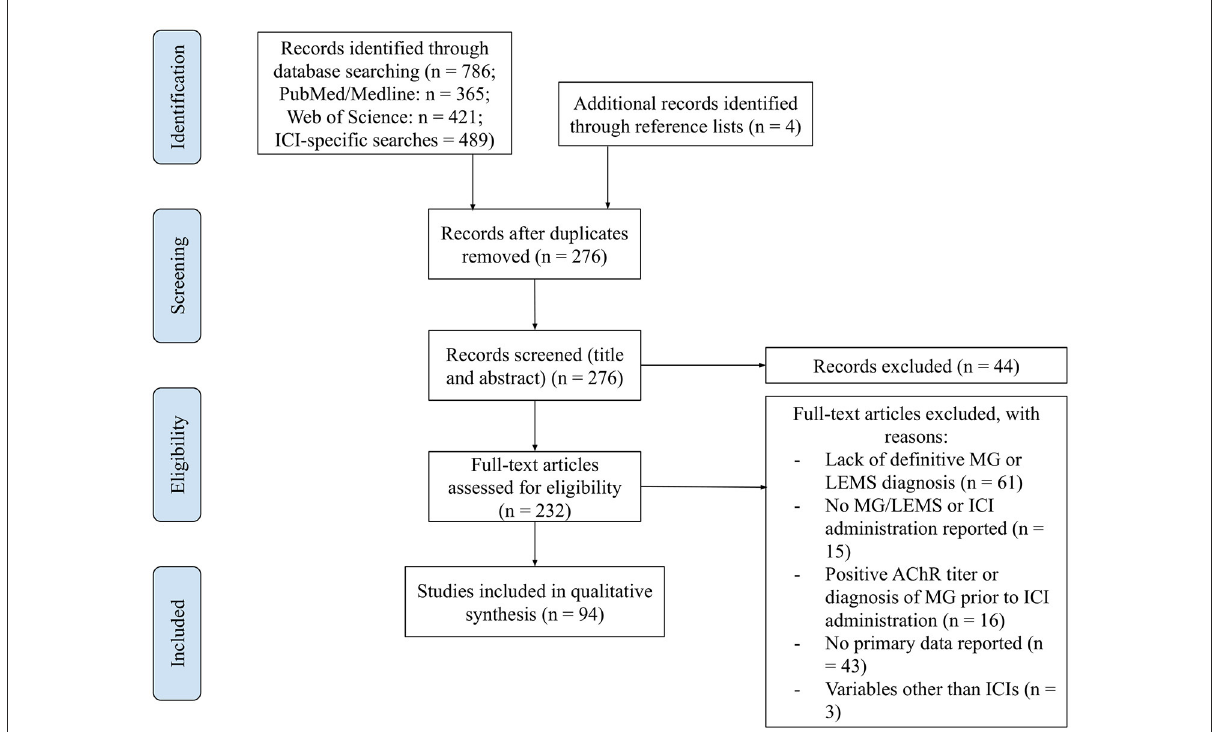
FIGURE1 PRISMA flow diagram: curation of records. Papers captured by search algorithms in PubMed ( n = 786) and additional records identified through reference lists ( n = 4) were manually curated to remove duplicates ( n = 276). The titles and abstracts of these papers were screened to assess whether they met the inclusion and exclusion criteria, yielding a total of 232 papers. These full-text articles were then assessed for eligibility, excluding 138 for various reasons. Ninety-four papers were included in the qualitative